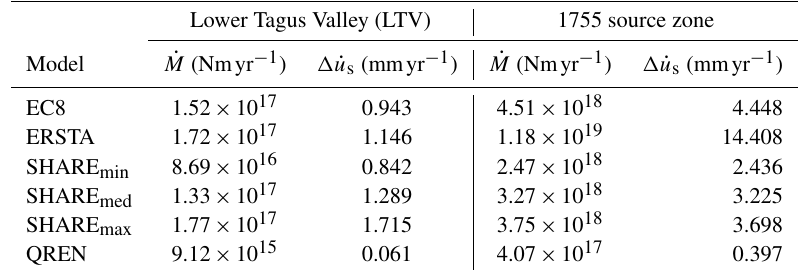
Table 8. Simple test: seismic deformation rates ( (cid:49) ˙ u s ) in millimetres per year (mmyr − 1 ) for the LTV and 1755 source zones considering four earthquake recurrence models. ˙ M is the long-term seismic moment rate.